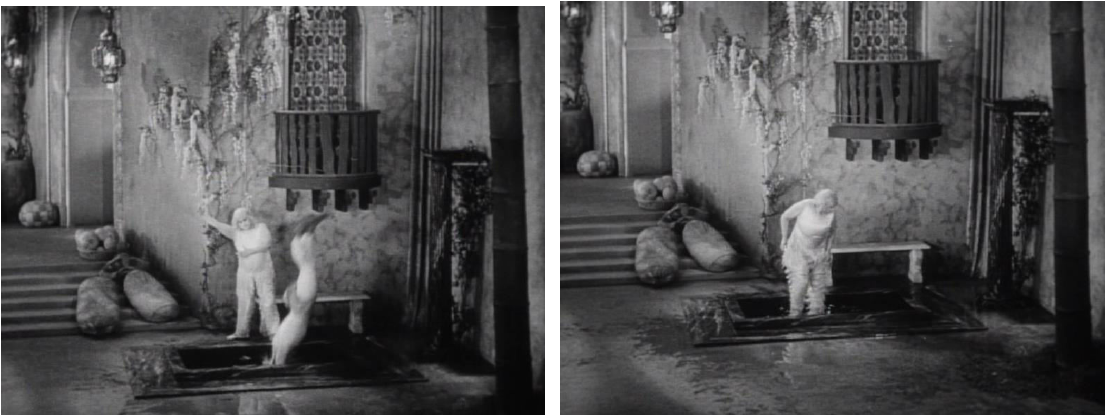
Figures 8 and 9. For the movie-in-the-movie of Free and Easy , Elmer mysteriously dives and disappears into an ankle-deep pool, leaving the Queen